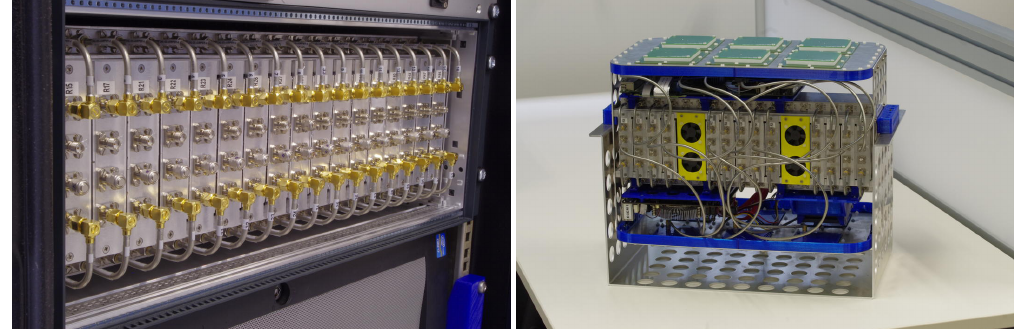
Figure 9. Left : RF front-end of the SPIR Instrument. The control and recording system is implemented in a standard industrial PC. Right : SPIR-UAV instrument to be flown on-board a UAV for the remote sensing of the sea-surface ice of the